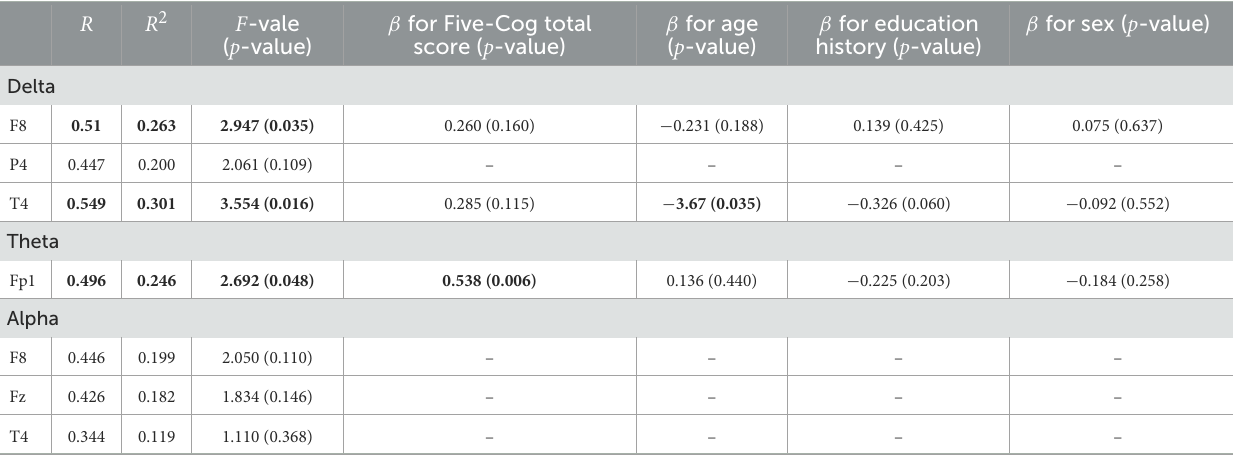
TABLE 4 Summary of multiple linear regression analysis for betweenness centrality (BC).